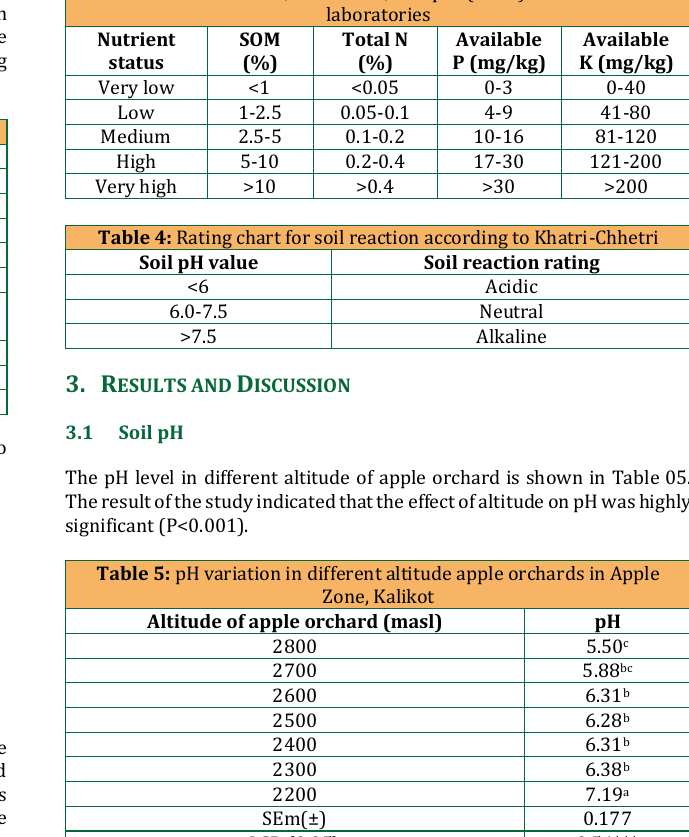
Table 3: Rating chart for classification of fertility status according to Soil Science Division, Khumaltar, Lalitpur (2002) and Ward lab